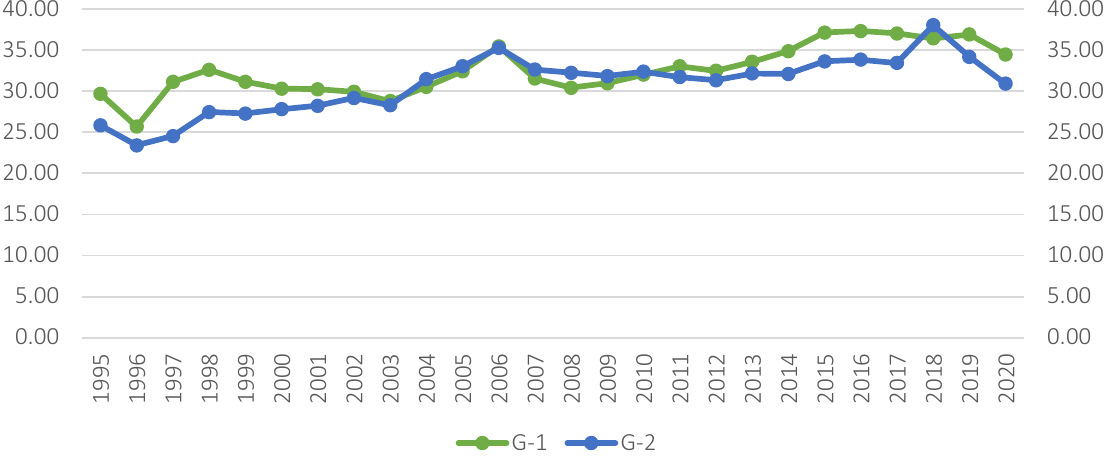
Figure 1. Dynamics of interregional ( G